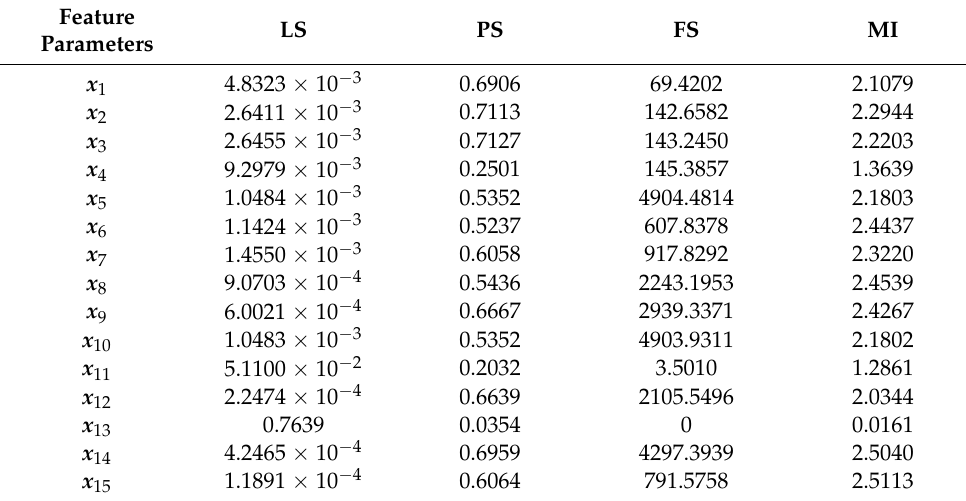
Table 4. Evaluation score of four types of characteristics.